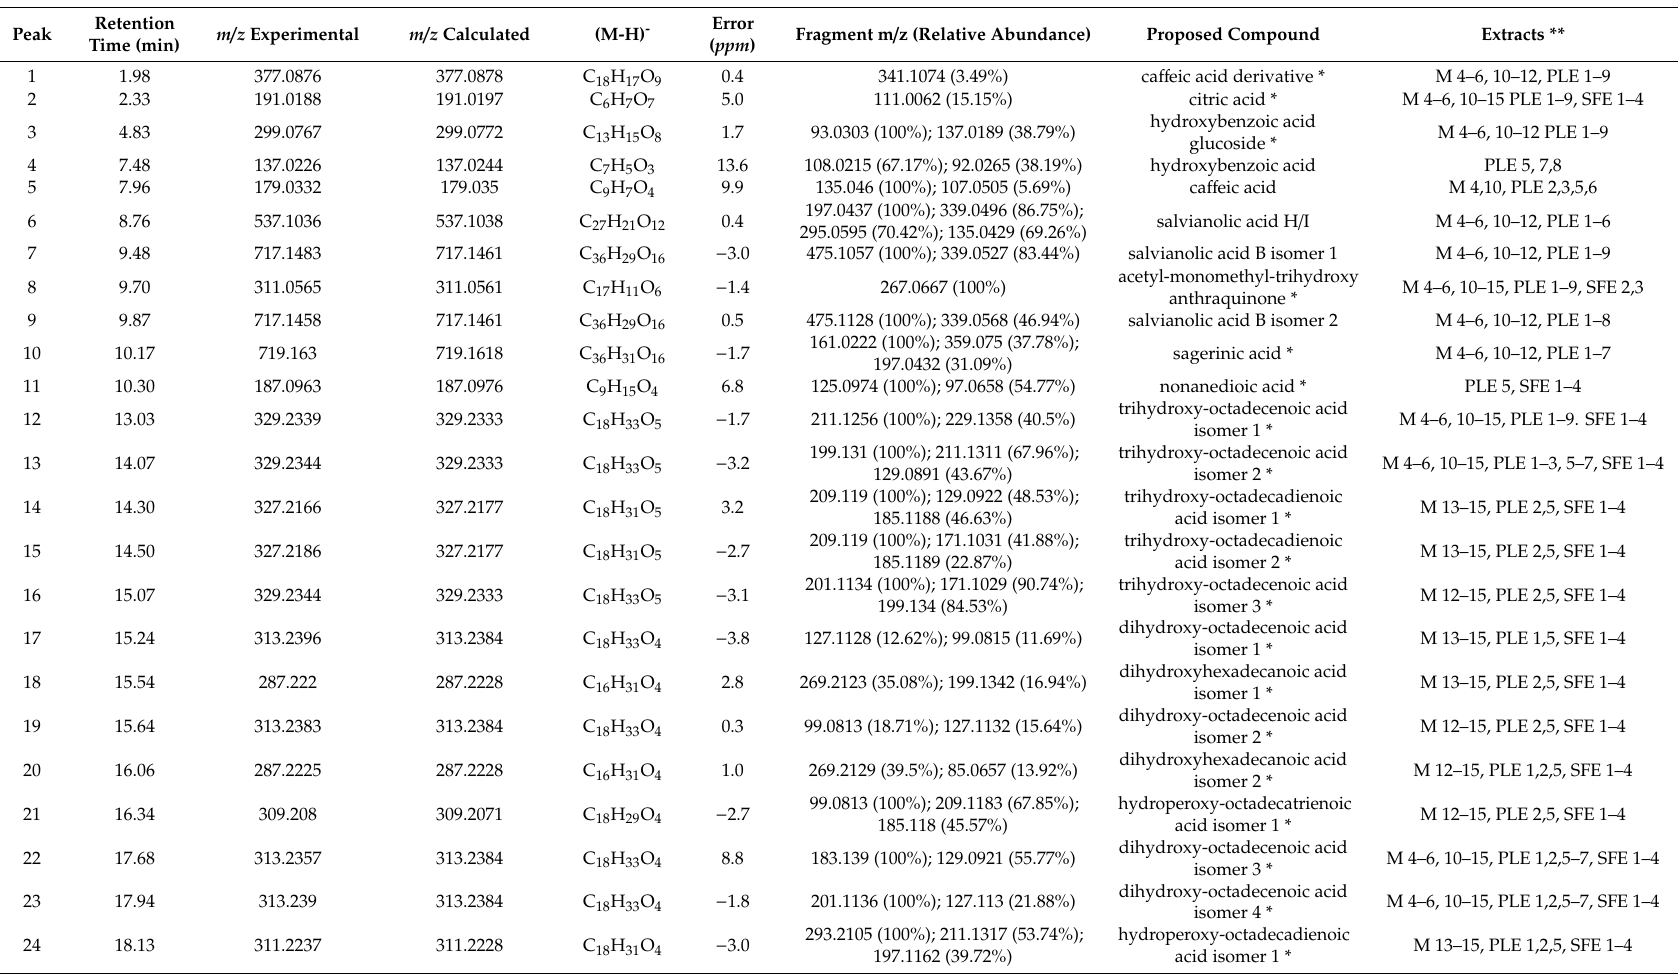
Table 1. Proposed compounds tentatively identified in S. o ffi cinale root extracts obtained by di ff erent extraction techniques using HPLC-ESI-QTOF-MS. Numbers designing compounds correspond to peaks as depicted in Figure